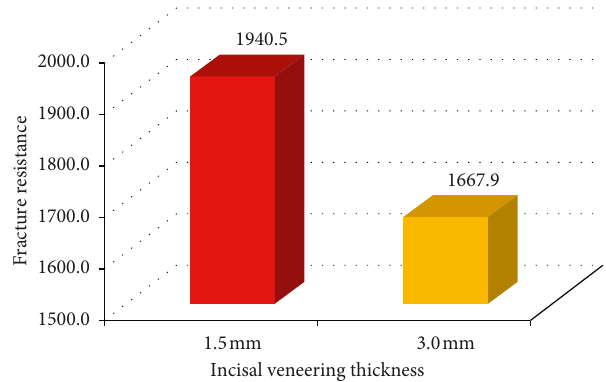
1500.0 Figure 15: Bar chart showing fracture resistance of two incisal veneering thicknesses in the nickel-chromium metal ceramic